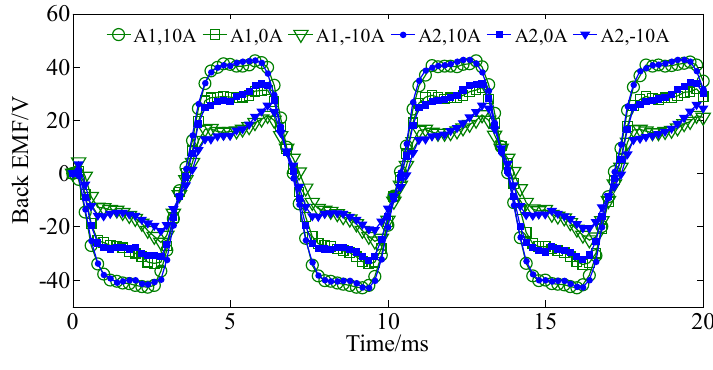
Figure 9. Back EMF waveforms.